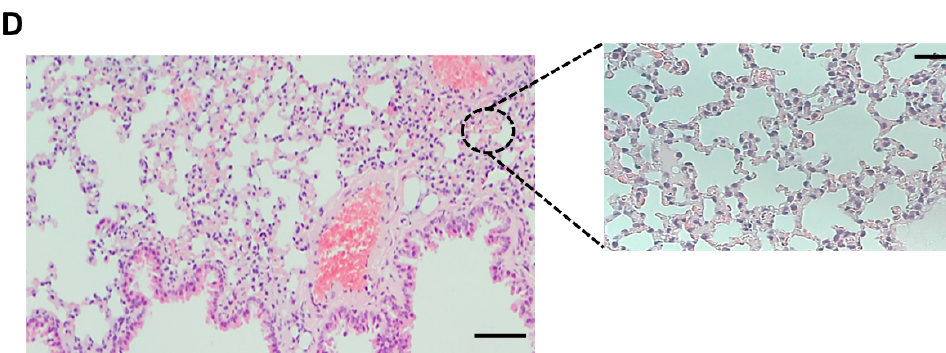
Figure 4. SSi6 treatment prevents spontaneous metastasis for lungs in an orthotopic model. MDA- MB-231 stably transduced with lentivector-luciferase was used to track cells by bioimaging after surgical transplantation into the mammary tissue of athymic nude mice. ( A ) Representative ex vivo bioluminescence images of lung from the vehicle and SSi6 15 mg/kg-treated mice. ( B ) Quantification of total flux at study endpoint. p -values were generated by Student’s t -test (* p < 0.05, ** p < 0.001). H&E-stained lung with areas marked with tumor growth of ( C ) vehicle and ( D ) SSi6 group. Images represent results in each treatment group, scale bar = 200 µ m (low magnification) and 50 µ m (high magnification).